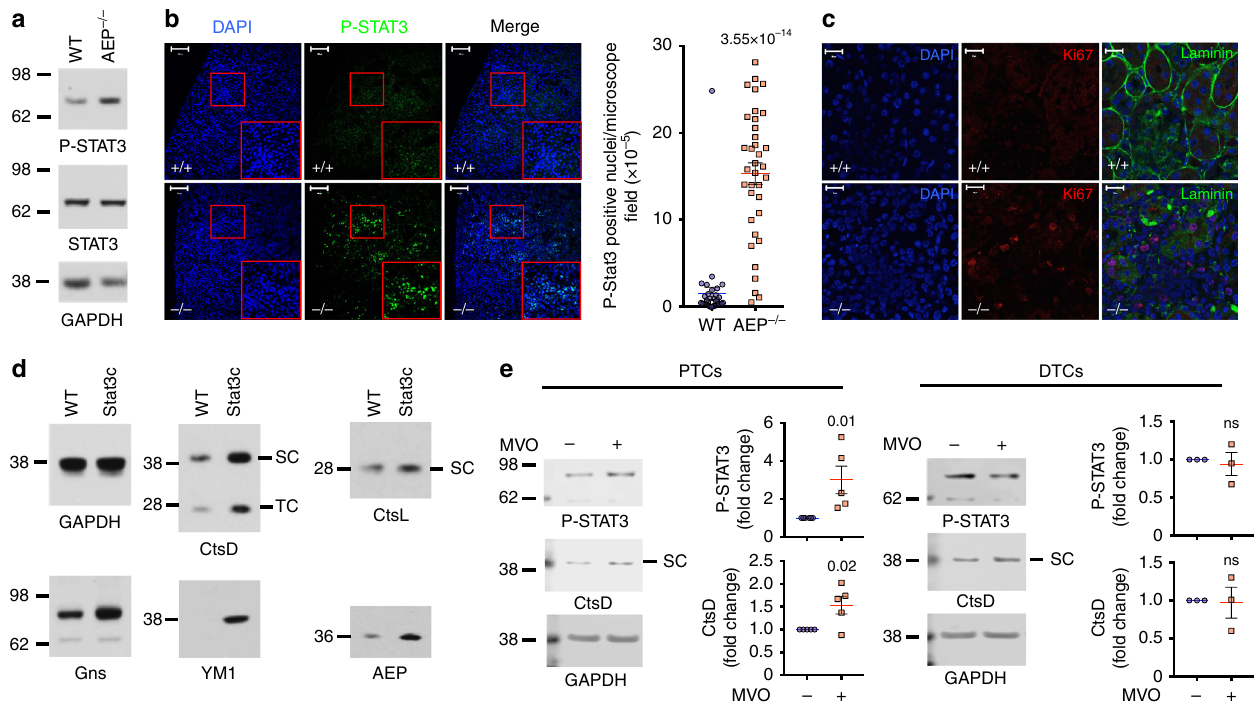
Fig. 8 Activation of STAT3 in AEP − / − kidney and enhanced hydrolase expression in STAT3c kidneys. a STAT3 and P-STAT3 levels in WT and AEP − / − kidneys. b P-STAT3 detected by IF in WT and AEP − / − kidney sections. Right panel shows quantitation of the number of P-STAT3 positive nuclei per area ( n = 35 microscopic fi elds). (Scale bar = 100 μ m). Statistical signi fi cance was calculated using a two-sided unpaired t- test. c Ki67 and laminin detected by IF in WT and AEP − / − kidney sections. (Scale bar = 20 μ m). d Similar proteins accumulate in STAT3c and AEP − / − kidney. e Levels of P-STAT3 and CtsD